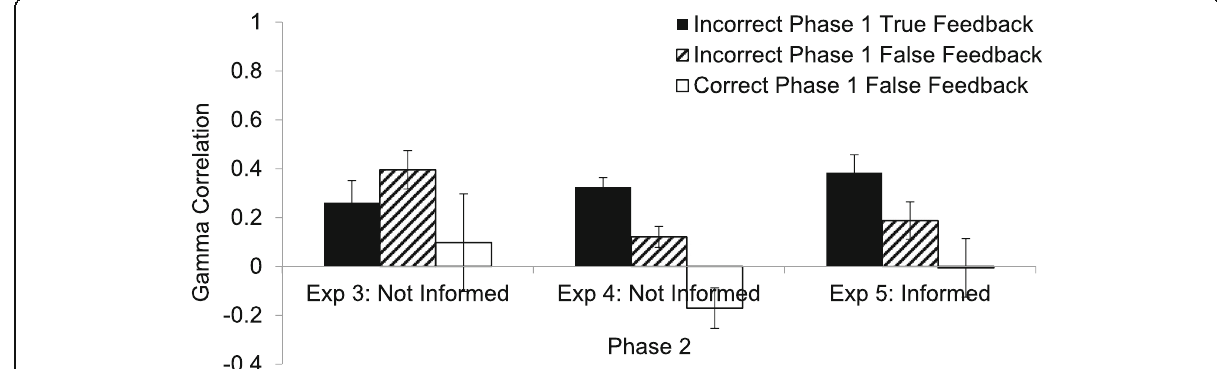
Fig. 3 The γ correlations between confidence in the factual accuracy of responses on the initial, Phase 1 test and correct performance in Phase 2, in which recalling the feedback word, regardless of whether it was true or false, was considered correct. The solid black bar represents the standard hypercorrection condition in which the participant answered incorrectly in Phase 1 and was given true feedback. The hatched bar represents the condition in which the participant answered incorrectly in Phase 1 and was given false feedback. The white bar indicates the condition in which the participant answered correctly in Phase 1 and was given false feedback. When people were correct in Phase 1 and then were given correct feedback, they were, of course, virtually always correct, making it impossible to compute gammas in this condition. So, this condition is not included in this graph. In the left and center are the results from Experiments 3 and 4, respectively, in which participants were not informed about whether the to-be-learned word, provided as feedback, was true or false. On the right are the results from Experiment 5 in which participants were informed, immediately upon being presented with the to-be-learned word in red, whether that feedback was true or false, and, if false, what the true answer was. Error bars indicate the standard error of